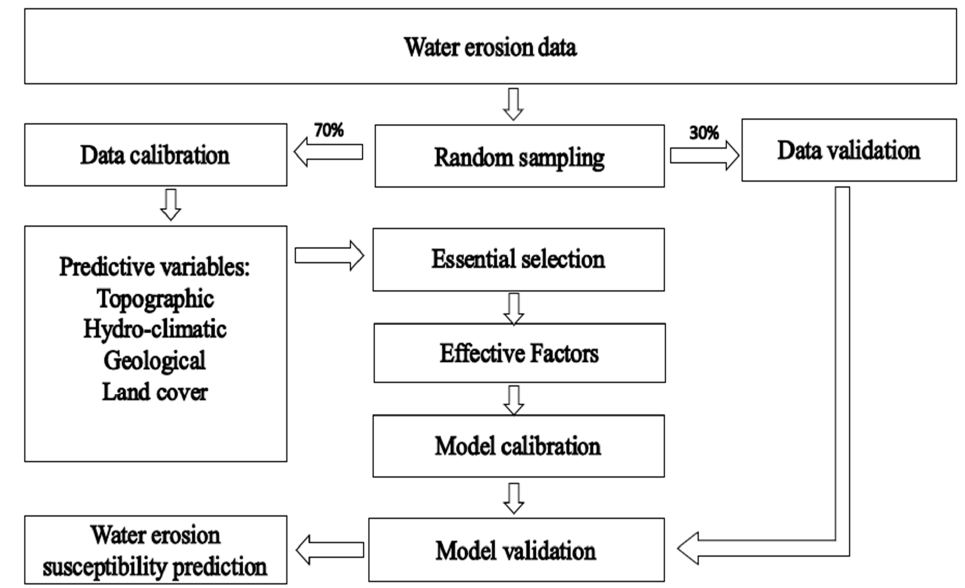
Figure 2. Schematic representation of the proposed method.